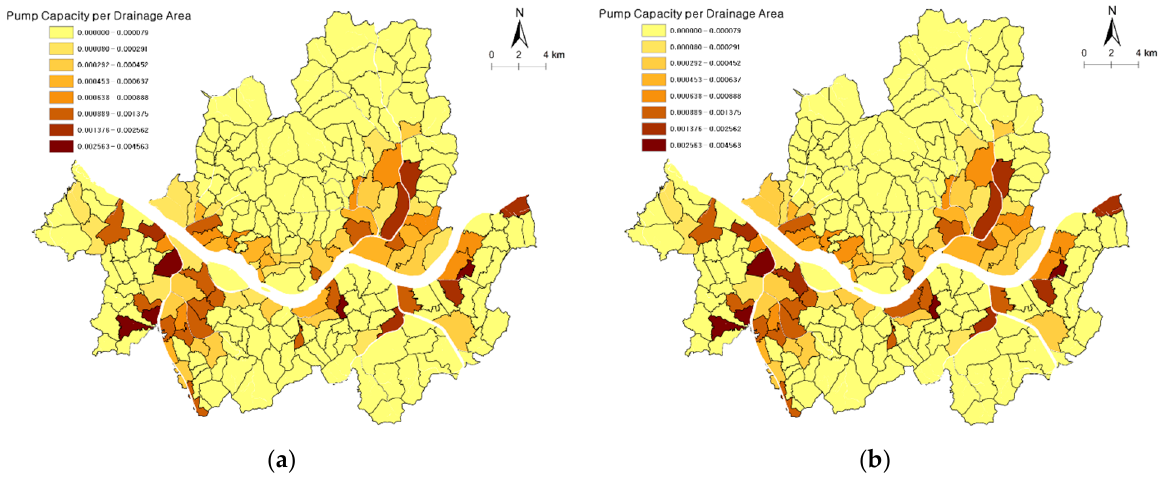
Figure 11. Density of drainage pump capacity by year: ( a ) September 2010; ( b ) July 2011.